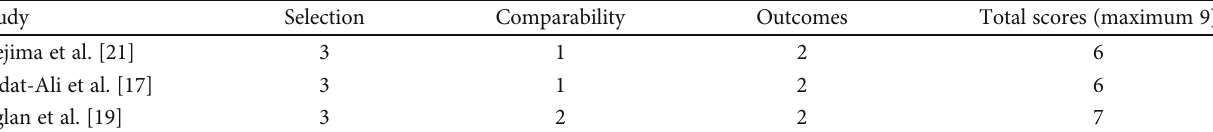
Table 2: The Newcastle-Ottawa Scale (NOS) for assessing the quality of non-RCTs.